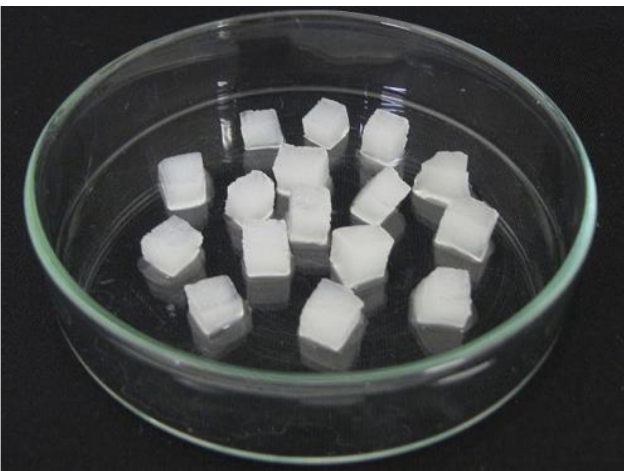
Figure 3. Immobilized enzyme prepared with κ -carrageenan. Immobilized enzymes were prepared using 1.5 – 4.0% ( w / v ) κ -carrageenan and crude enzymes AlyFRA or AlyFRB, which were cut into cubes of approximately 5 mm.